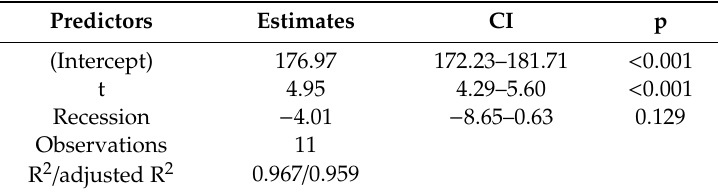
Table 7. Model 2 results for higher education sector.